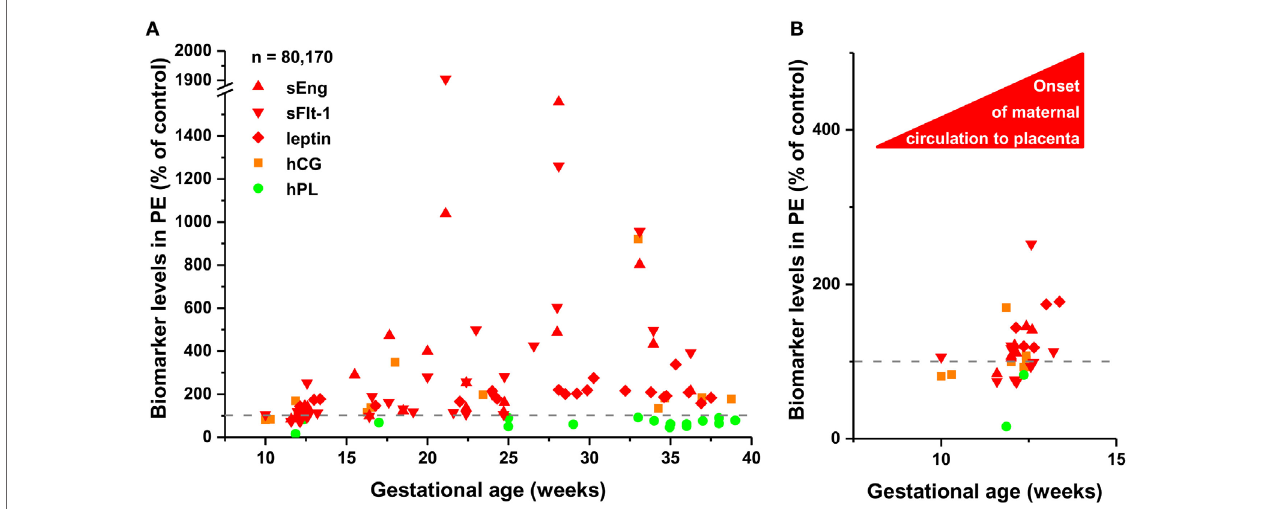
FigUre 5 | The timing of gene module dysregulation in preterm preeclampsia. (a) A database of 80,170 measurements published in 61 reports (35, 61, 82, 88, 126, 178–233) was built for “virtual” liquid biopsy of the placenta in preterm preeclampsia with maternal blood levels of proteins with the highest expression in the placenta among all tissues [i.e. hCG, human placental lactogen (hPL), sEng, sFlt-1, and leptin]. Levels of these biomarkers in preterm preeclampsia were expressed as the percentage of control levels (dashed line) and were represented in scatter plots by different colors reflecting gene module classification. Based on qRT-PCR data, sEng belongs to module M2 (red). hPL (M1, green module) levels in preeclampsia were constantly below control levels during gestation, while the levels of module M2 biomarkers in preeclampsia had continuous elevation compared to control levels as a function of gestational age. (B) Analysis of first trimester data revealed the lower expression of all biomarkers in preeclampsia than in controls before the onset of maternal circulation, and the increasing expression of module M2 biomarkers in preeclampsia compared to controls after 12 weeks of gestation.